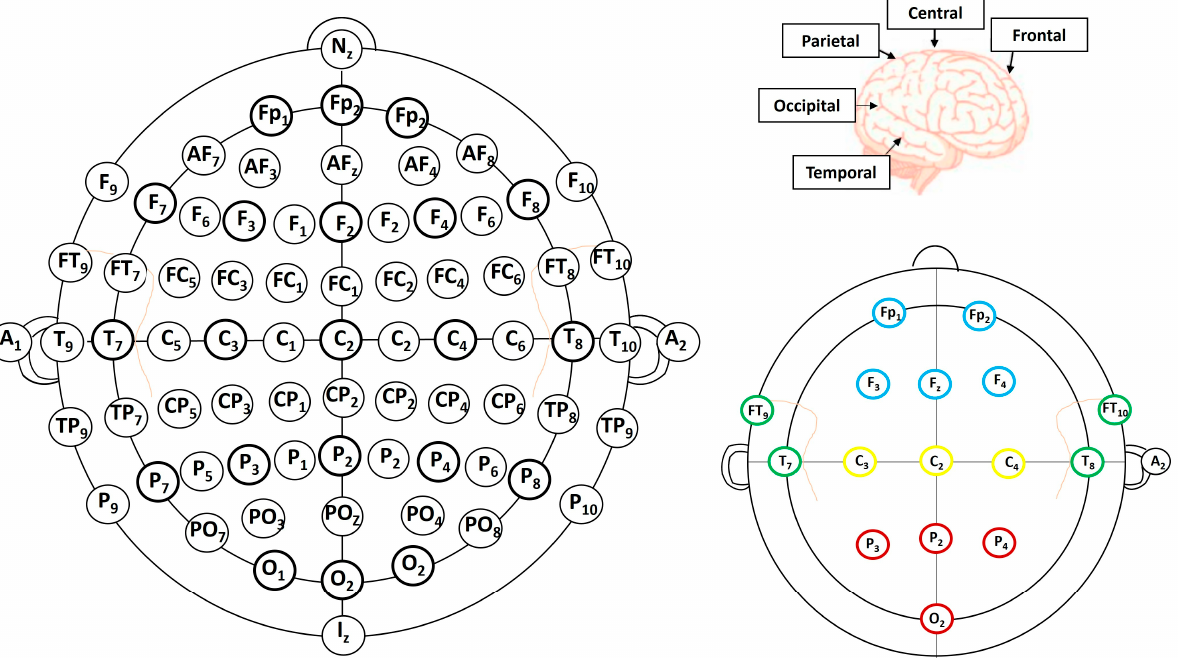
Figure 1. Brain lobes and electrode placements